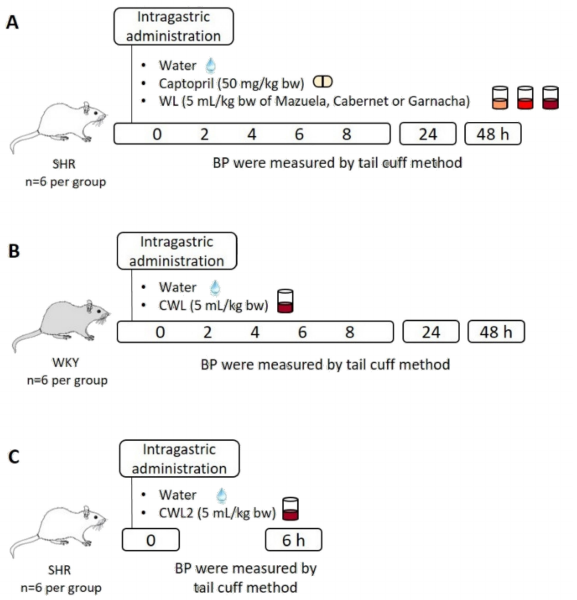
Figure 1. Graphical representation of the three in vivo studies carried out to investigate ( A ) the effect of three wine lees (WL) on blood pressure (BP) in spontaneously hypertensive rats (SHR), ( B ) the effect of Cabernet WL (CWL) on BP in normotensive Wistar–Kyoto rats (WKY) and ( C ) the effect of CWL from a different harvest (CWL2) at 6 h post-administration in